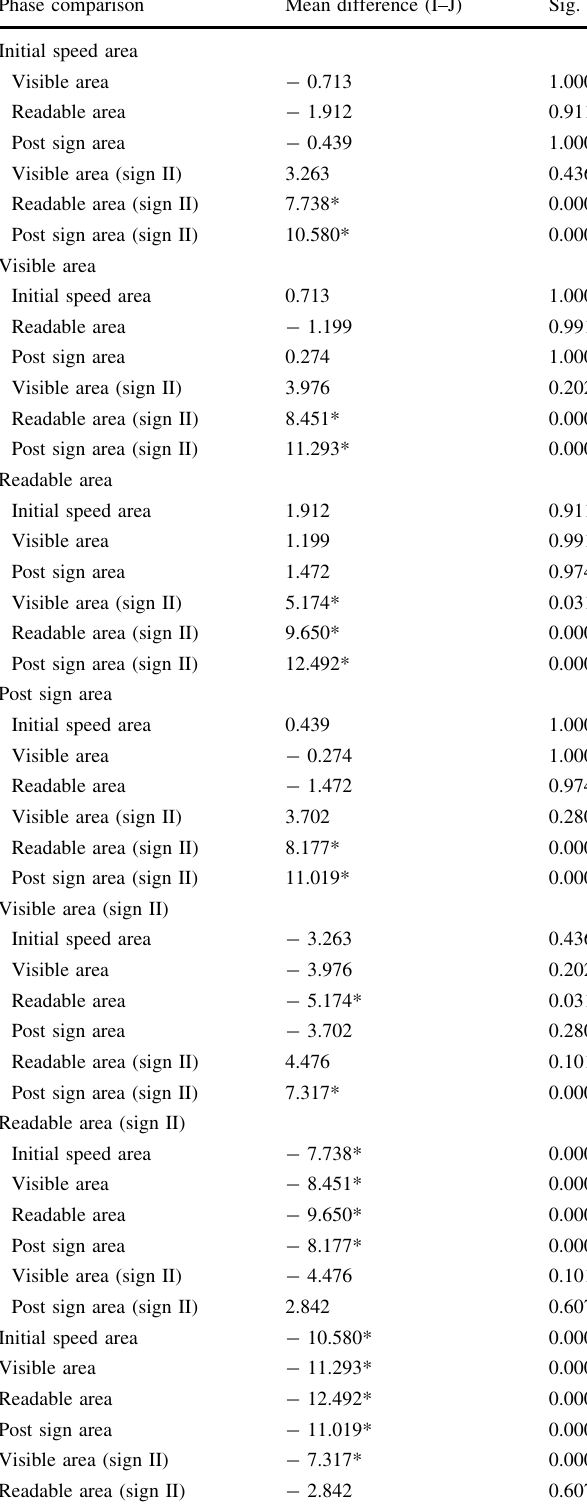
Table 3 Tukey’s post hoc analysis — work zone photo enforced